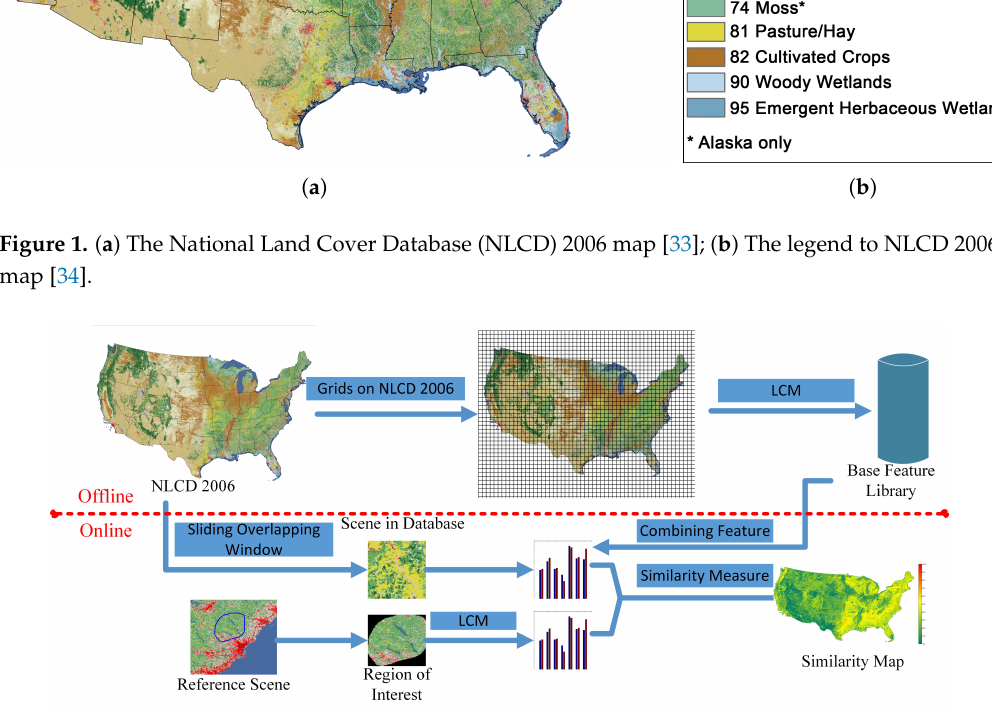
Figure 2. Basic framework of the proposed content-based map retrieval (CBMR) system. LCM: label co-occurrence